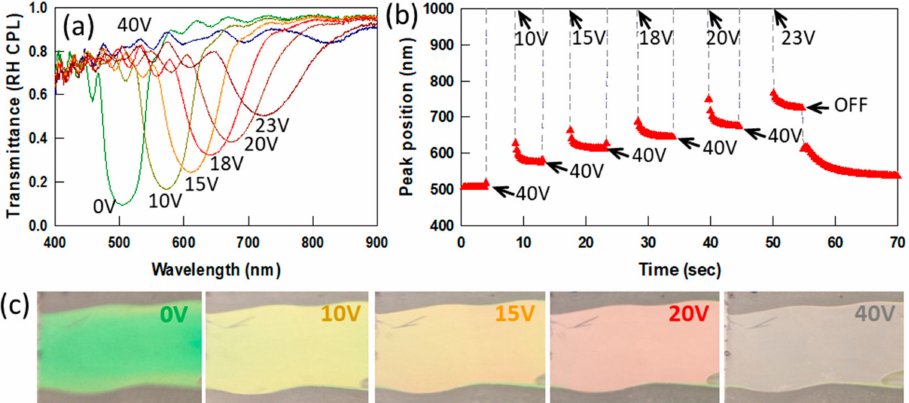
Figure 6. ( a ) Transmission spectra of a negative ∆ ε PSCLC with 3 ± 0.2 µ m thickness for DC voltages up to 40 V DC. ( b ) Peak position during the switching of the same PSCLC using various DC voltages. The arrows indicate the times at which the DC voltage was changed to the value indicated. ( c ) Photographs of the reflection color of the PSCLC as a function of applied DC